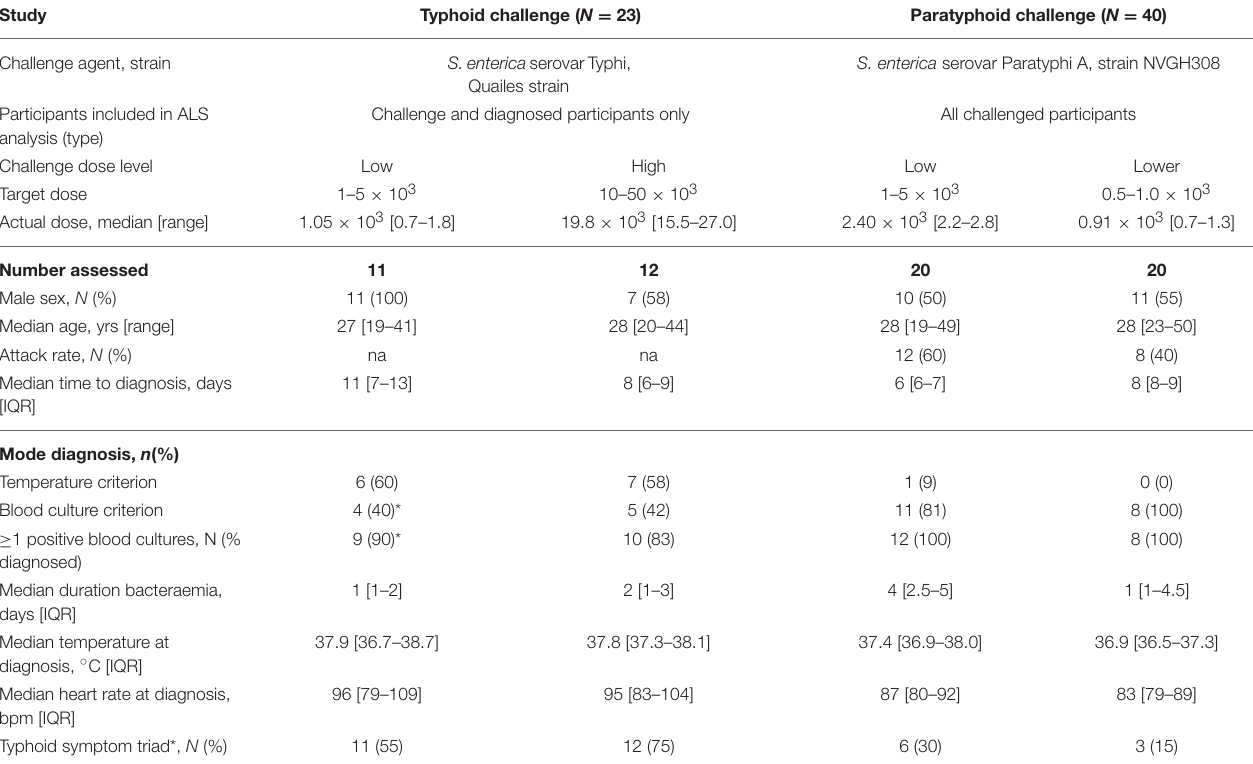
TABLE 1 | Oxford challenge studies: clinical parameters.